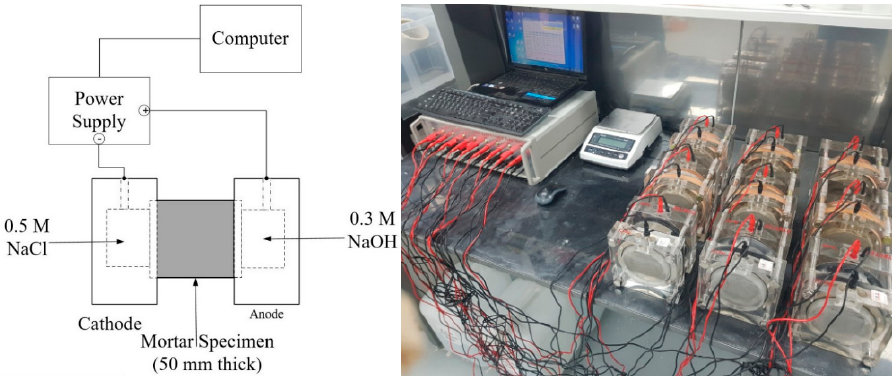
Figure 2. Test set-up for chloride migration testing.